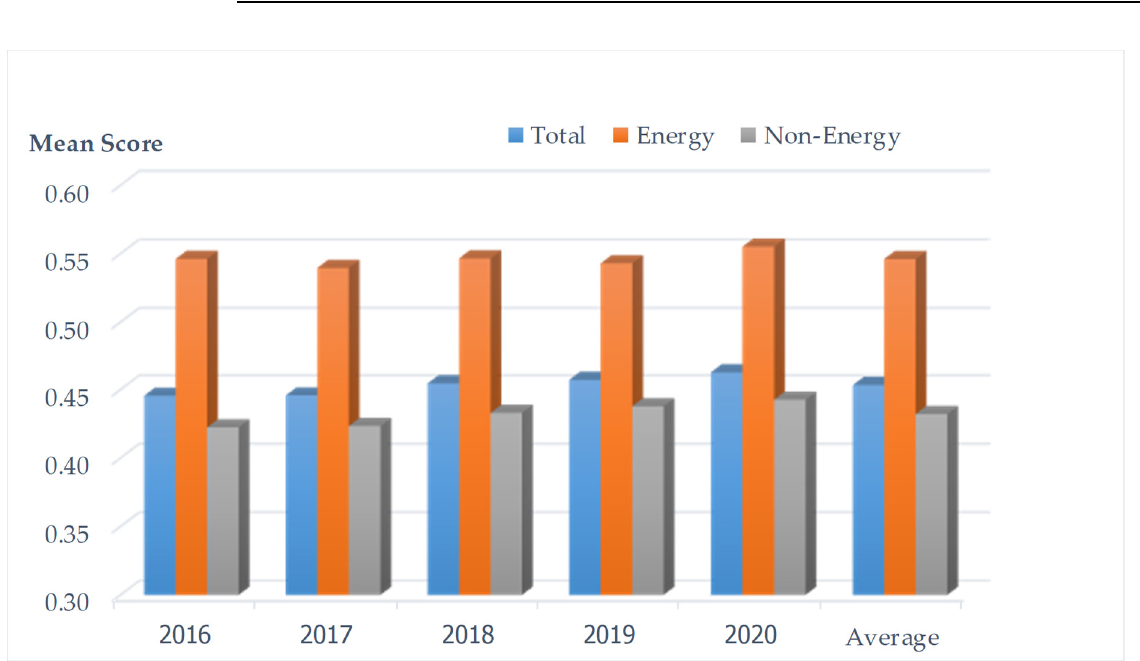
Figure 1. Energy scores of Thai listed companies.